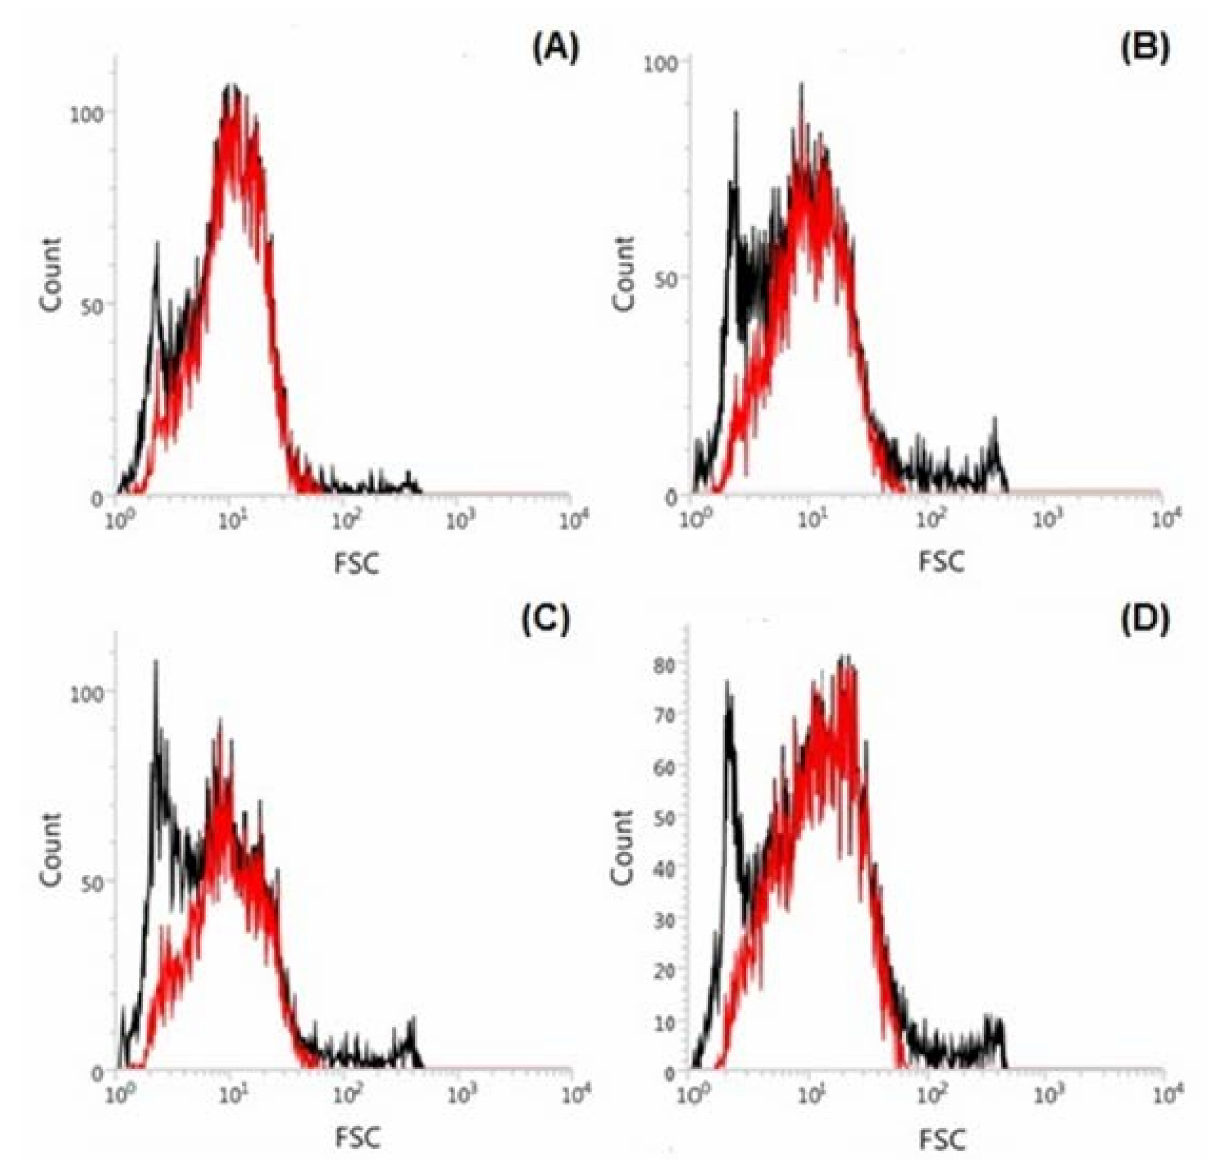
Figure 4. Graphical representation of the autofluorescence signal movement in Tetraselmis marina AC16 MESO (red curves). Flow cytometer histograms representing the excited autofluorescence signal in cells of T. marine AC16 MESO with 488 nm blue laser, at different concentrations of Zn 2+ . ( A ) 0 mg/L Zn 2+ ; ( B ) 5 mg/L Zn 2+ ; ( C ) 10 mg/L Zn 2+ ; ( D ) 20 mg/L Zn 2+